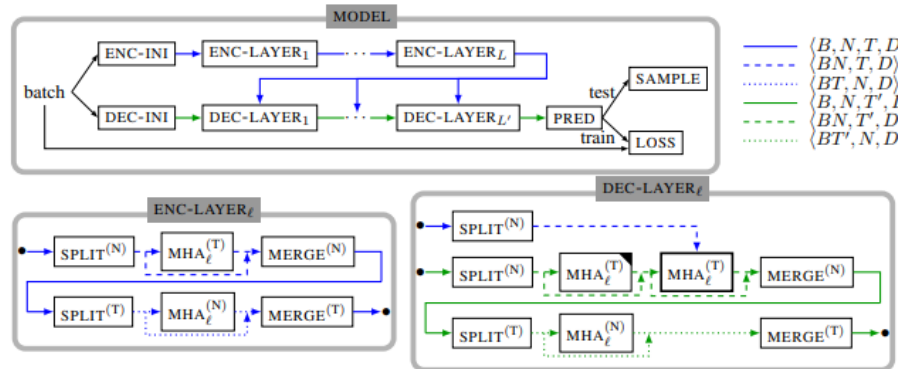
Figure 1. The architecture of ADN (from